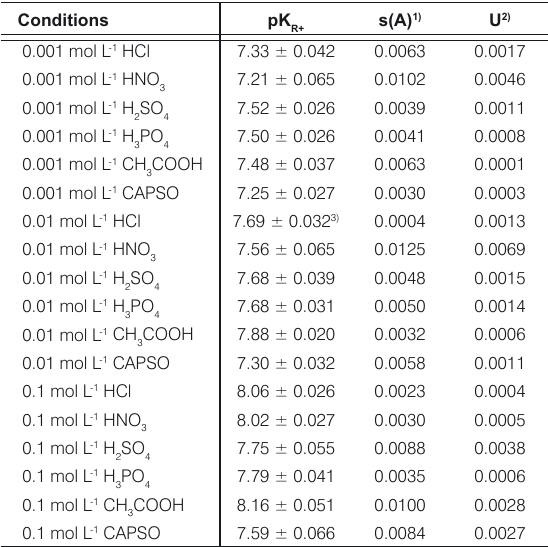
Table 2. pK constants of sanguinarine (and their standard R+ deviations) measured at different